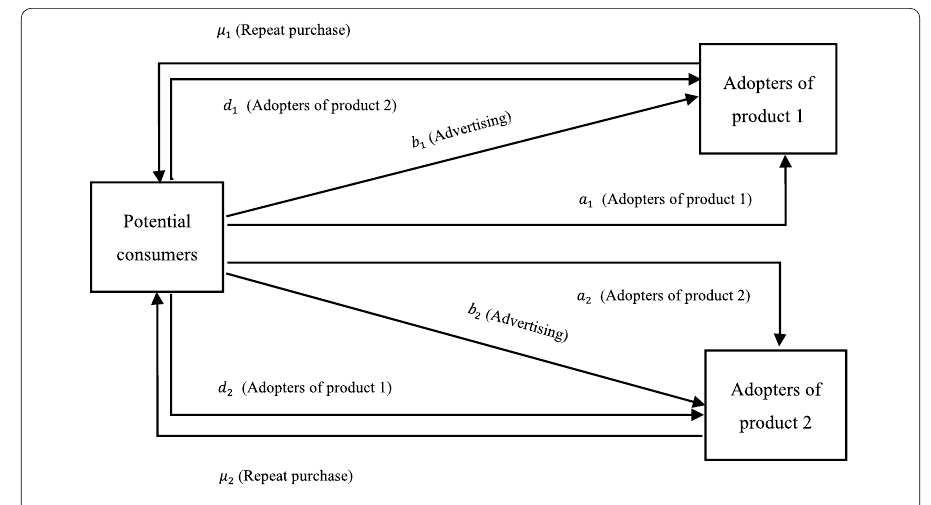
Figure 1 Node state transformation in the heterogeneous consumer social